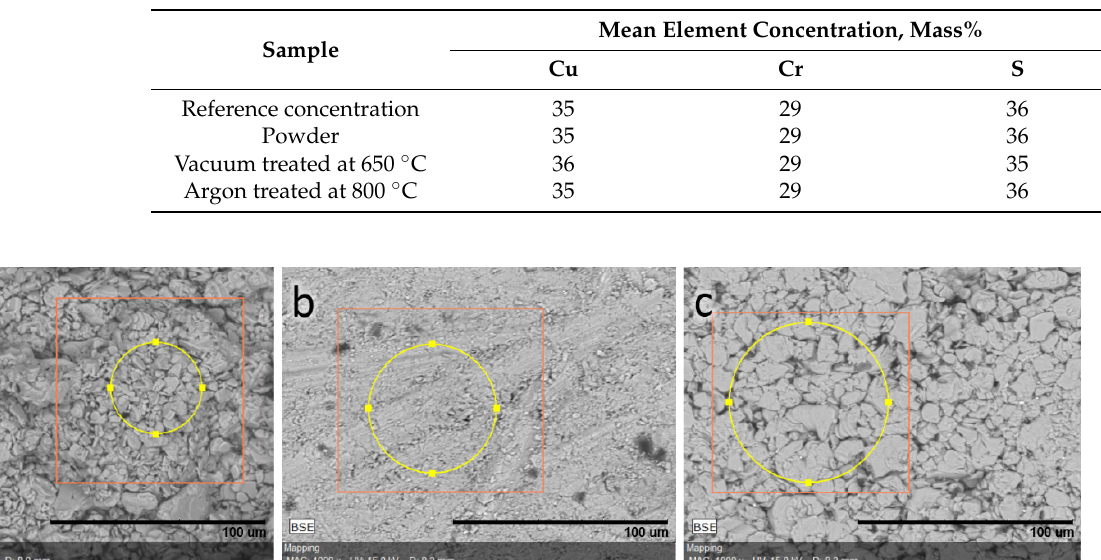
Table 2. Elemental composition of synthesized CuCrS 2 powder and ceramic samples.